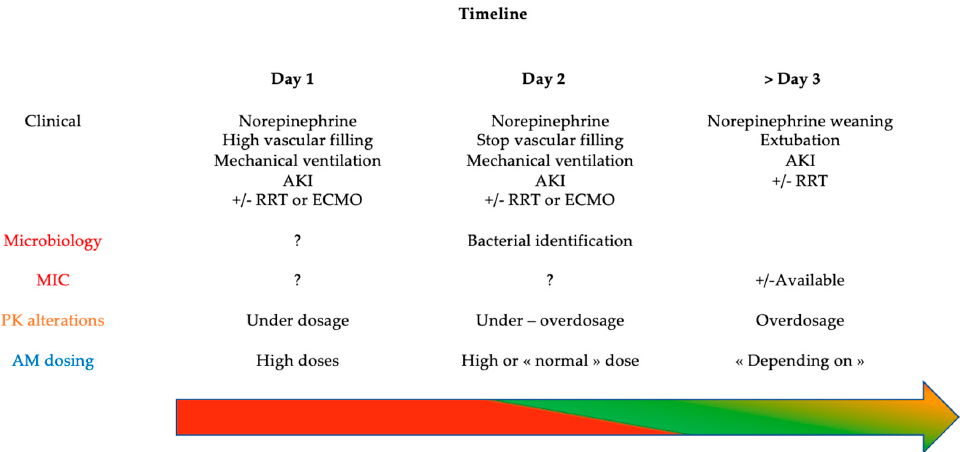
Figure 1. Timeline of PK/PD alterations in critically ill patients with septic shock. AKI: acute kidney injury, RRT: renal replacement therapy, ECMO: extracorporeal membrane oxygenation, VF: vascular filling, MIC: minimal inhibitory concentration, PK: pharmacokinetics, AM: antimicrobial; Arrow with color: level of inadequate BL concentration risk: red = very high, green = low, orange = variable.